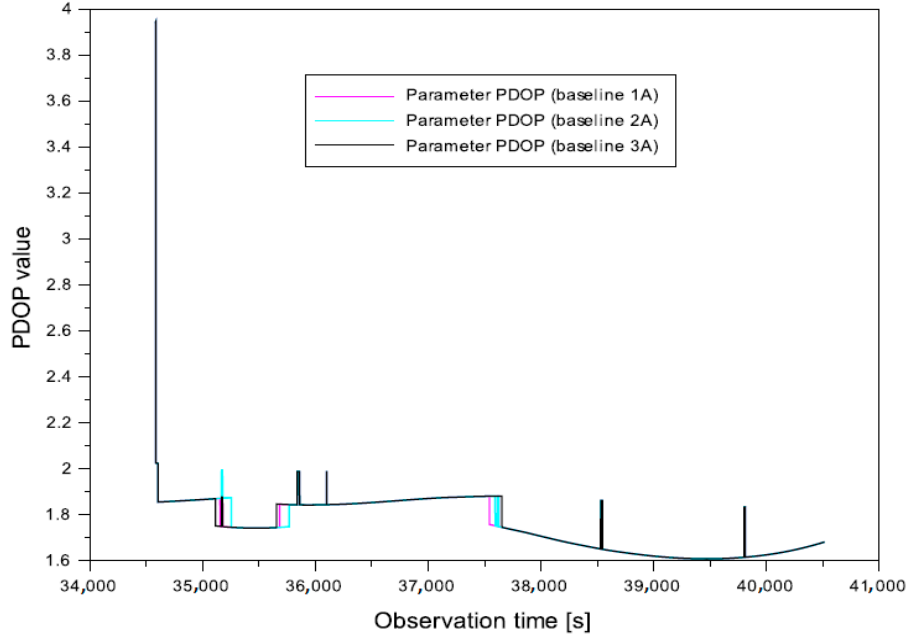
Figure 5. The results of PDOP values for each baseline.